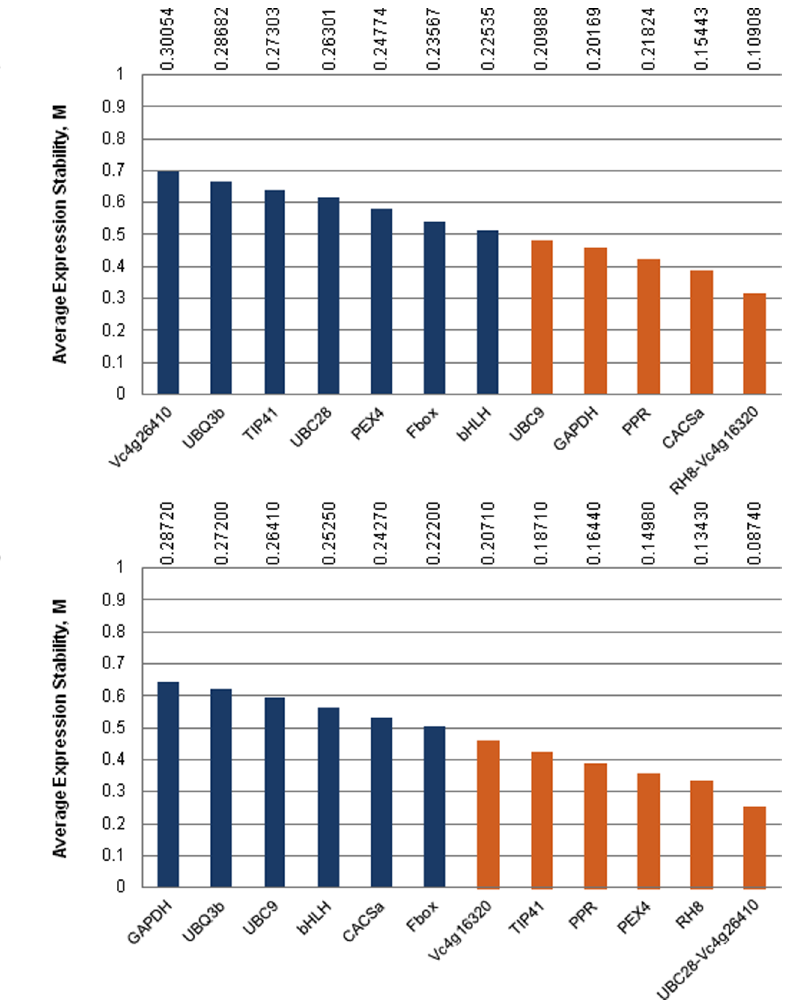
Figure 3. geNorm ranking of 13 reference genes from blueberry series. A. Floral bud series B. Fruit development series. Vertical numbers at the top indicate the CV values of the reference genes involved in the normalization. References showing highly stable expression ( M values , 0.5) are represented as orange bars.